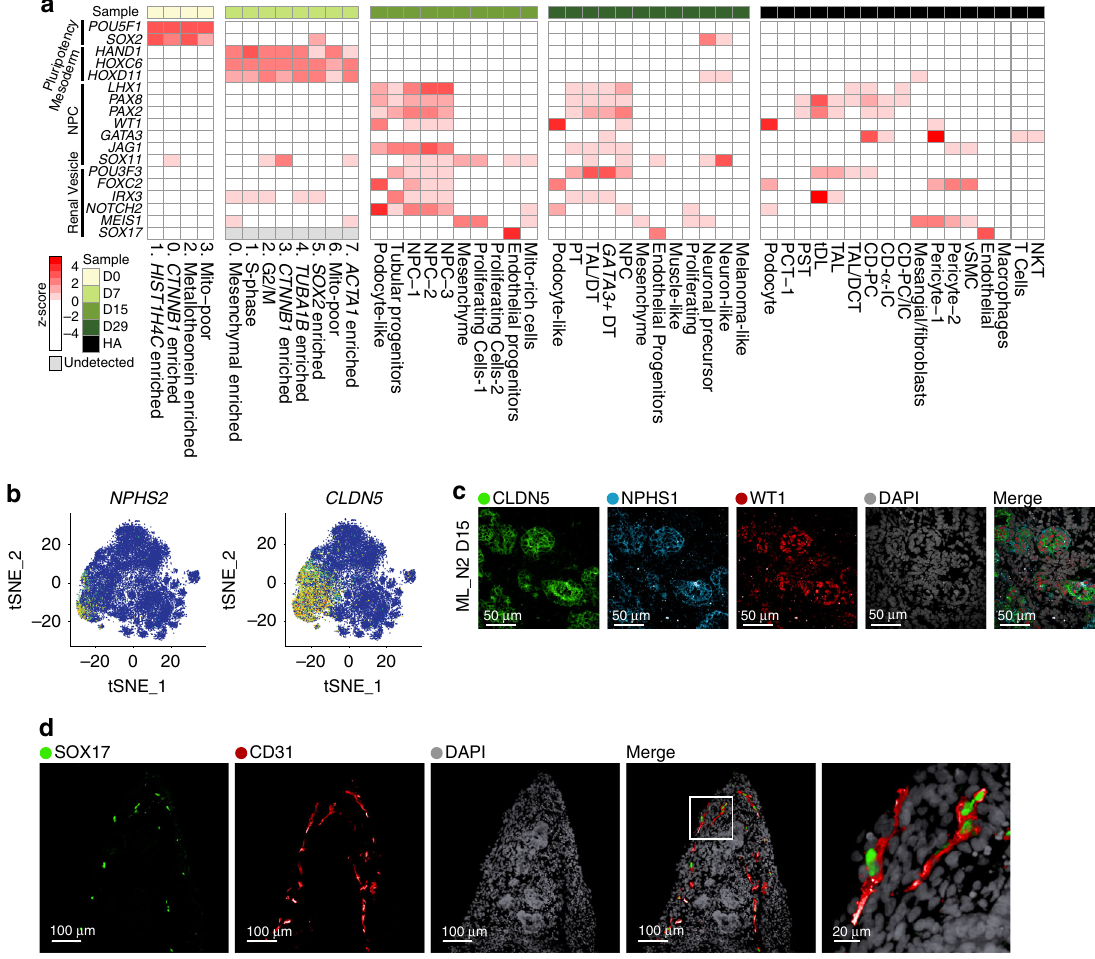
Fig. 4 Concordant expression of developmental programs across organoids from four human iPSC lines. a Heatmap of expression patterns for major nephrogenesis markers across organoid differentiation time points (iPSC D0, D7, D15, and D29, averaged across four cell lines, ML protocol) and human adult kidney. Expression values were row-normalized to obtain z -scores; red color indicates positive z -scores. b Canonical ( NPHS2 ) and data-derived ( CLDN5 ) podocyte marker genes superimposed in tSNE plots from D15 organoids (N2 line, ML protocol). c IF staining of D15 kidney organoid (N2 line, ML protocol) for CLDN5 as a marker of early podocyte differentiation derived from the single-cell data. Additional canonical podocyte markers (NPHS1, WT1) and DAPI staining as shown. d IF staining of D29 kidney organoid (AS line, ML protocol) for SOX17 and CD31, markers of endothelial